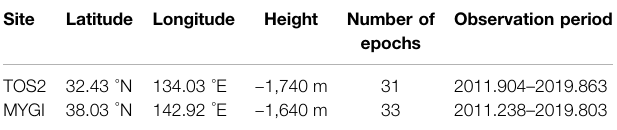
TABLE 3 | Locations and observation periods of the GNSS-A observation sites used in this study.